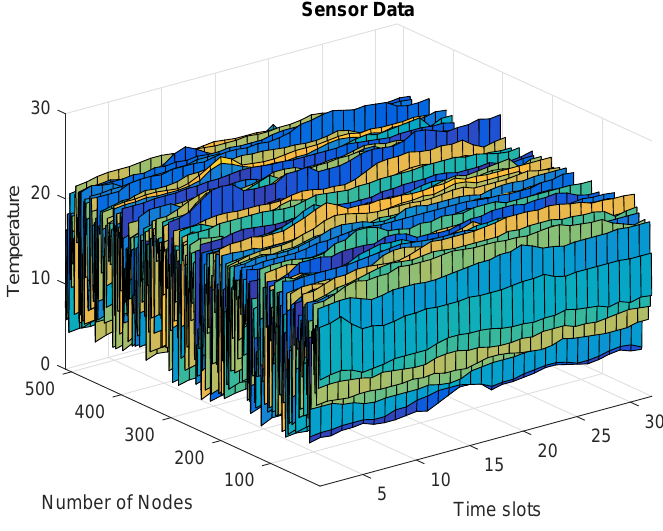
Figure 3. The spatial-temporal temperature data collected by 512 sensor nodes.